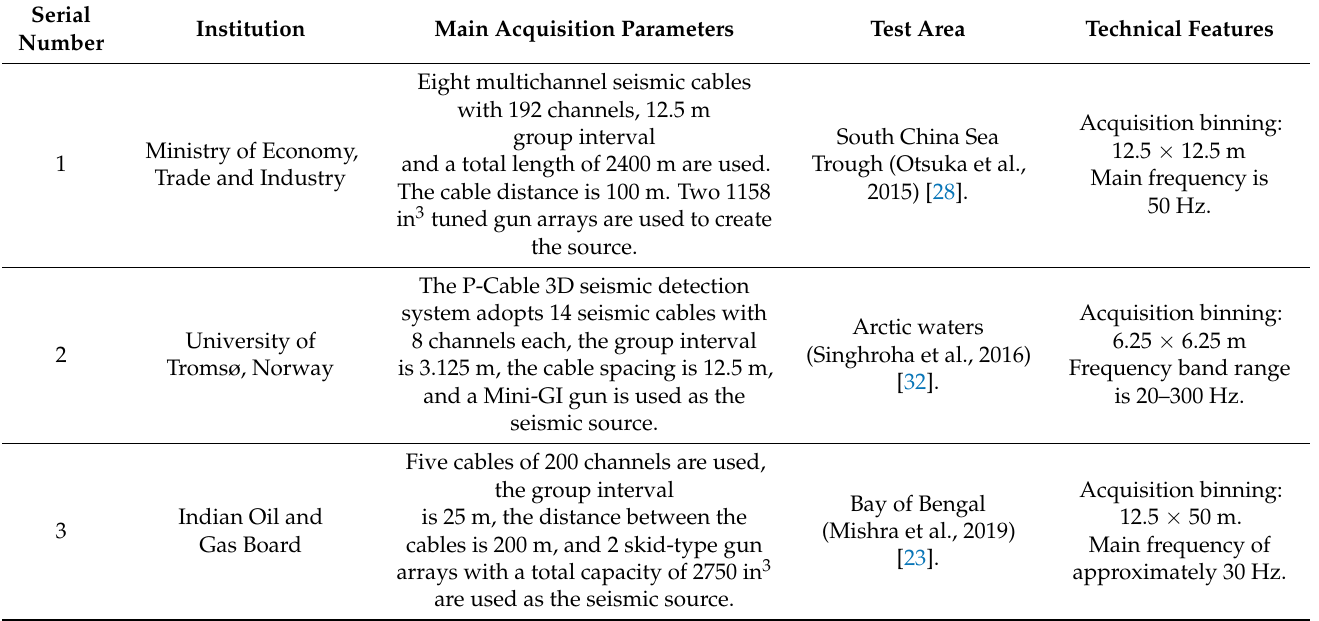
Table 1. Main institutions engaged in the seismic detection of gas hydrate and the technical charac- teristics of their